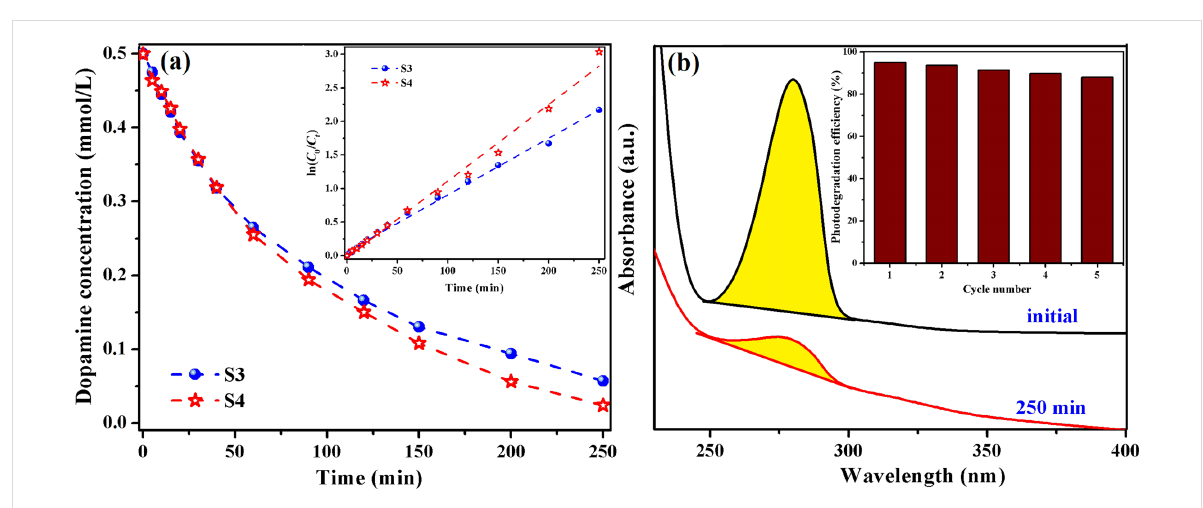
Figure 11: Dopamine concentration and fitted curves for the kinetic estimation (inset) of dopamine photodegradation under visible light in the pres- ence of S3 and S4 hybrid composites (a); changes of the UV–vis absorption spectra of an aqueous dopamine solution in presence of S4 composite film under visible irradiation (250 min) after five cycles of utilization (inset: effect of the re-use of S4 catalyst on the photodegradation efficiency of dopamine in the aqueous solution under visible light)